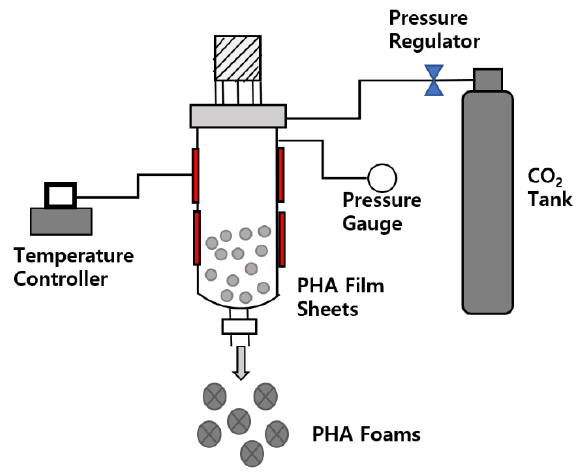
Figure 2. Schematic of supercritical CO 2 assisted foaming process.